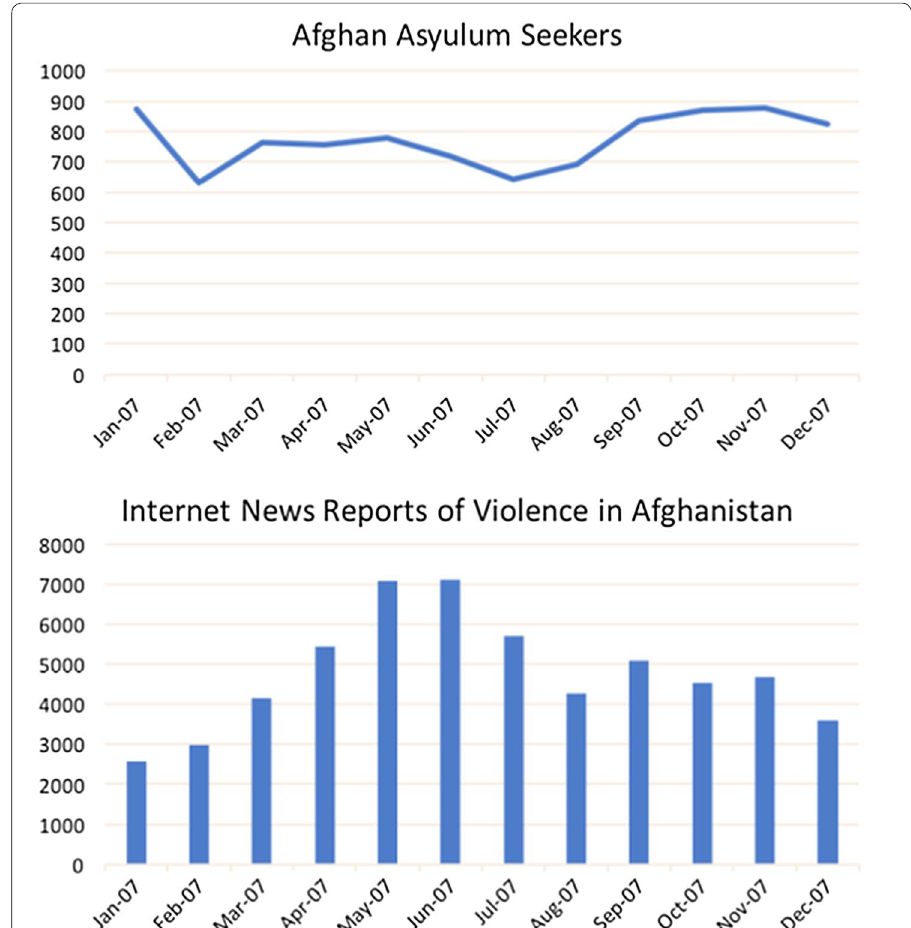
Fig. 5 Afghan asylum seekers and reports of violence in Afghanistan for each month of 2007